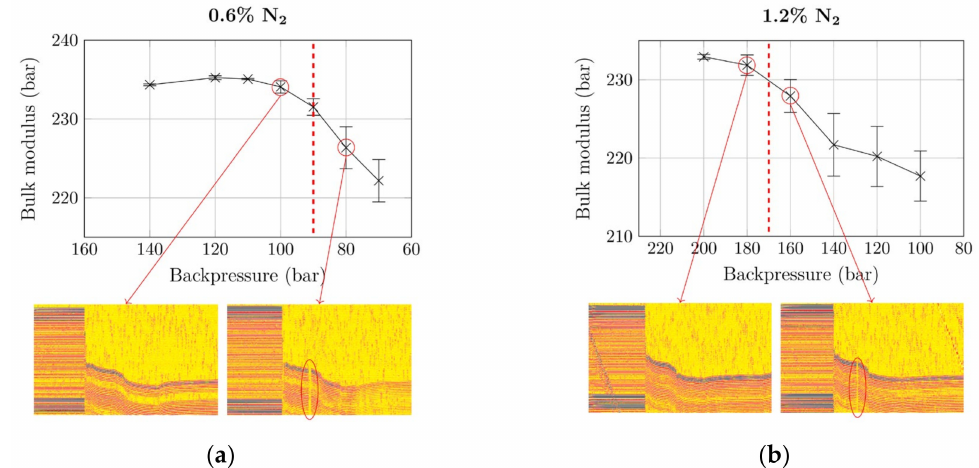
Figure 4. Development of bulk moduli with decreasing backpressure and ultrasound measurements for verification with ( a ) 0.6% N 2 and ( b ) 1.2% N 2 . The interruptions on the ultrasound signals stem from an undissolved gas phase (i.e., heterogeneous polymer-gas mixture). Dashed vertical line: